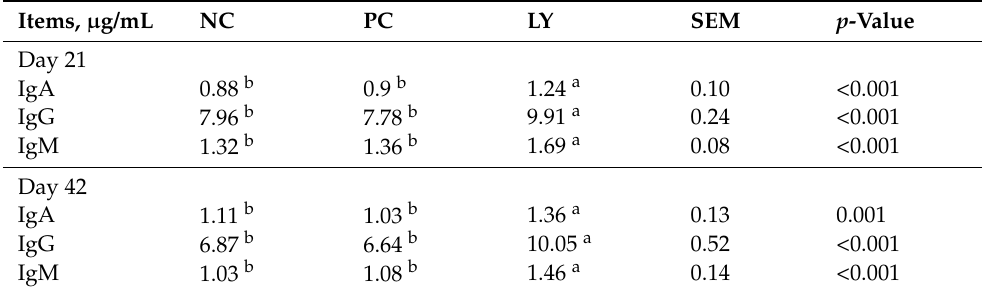
Table 5. Effect of dietary treatments on the serum immune index of